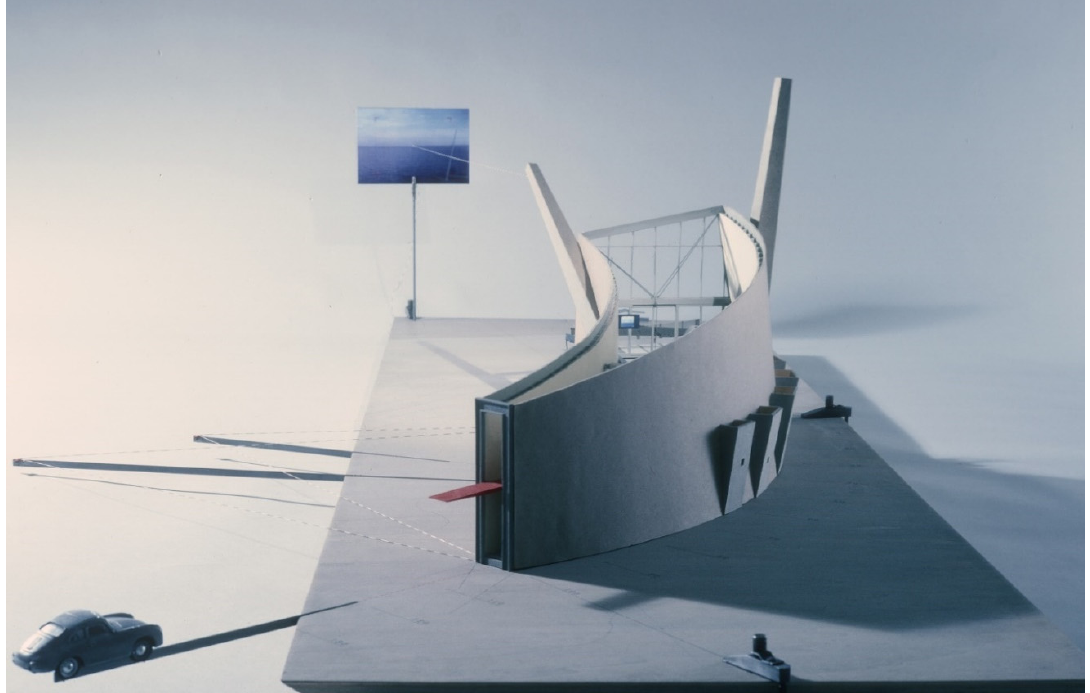
Figure 6. A model of a weekend house on Long Island, NY, USA (Slow House Project). Photo: © Diller and Scofidio 1991.